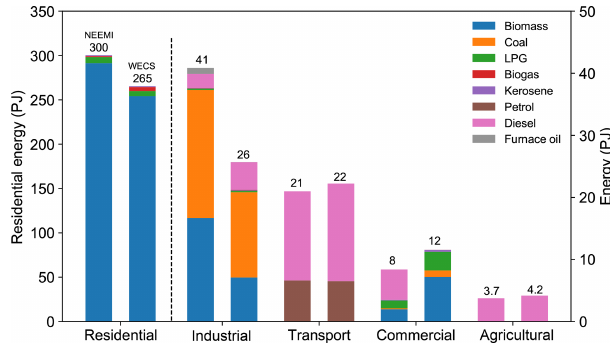
Figure 3. National energy consumption estimated for 2011; this study compared with WECS estimates. Residential sector (on left y axis) and industrial, transport, commercial and agricultural sec- tors (on right y